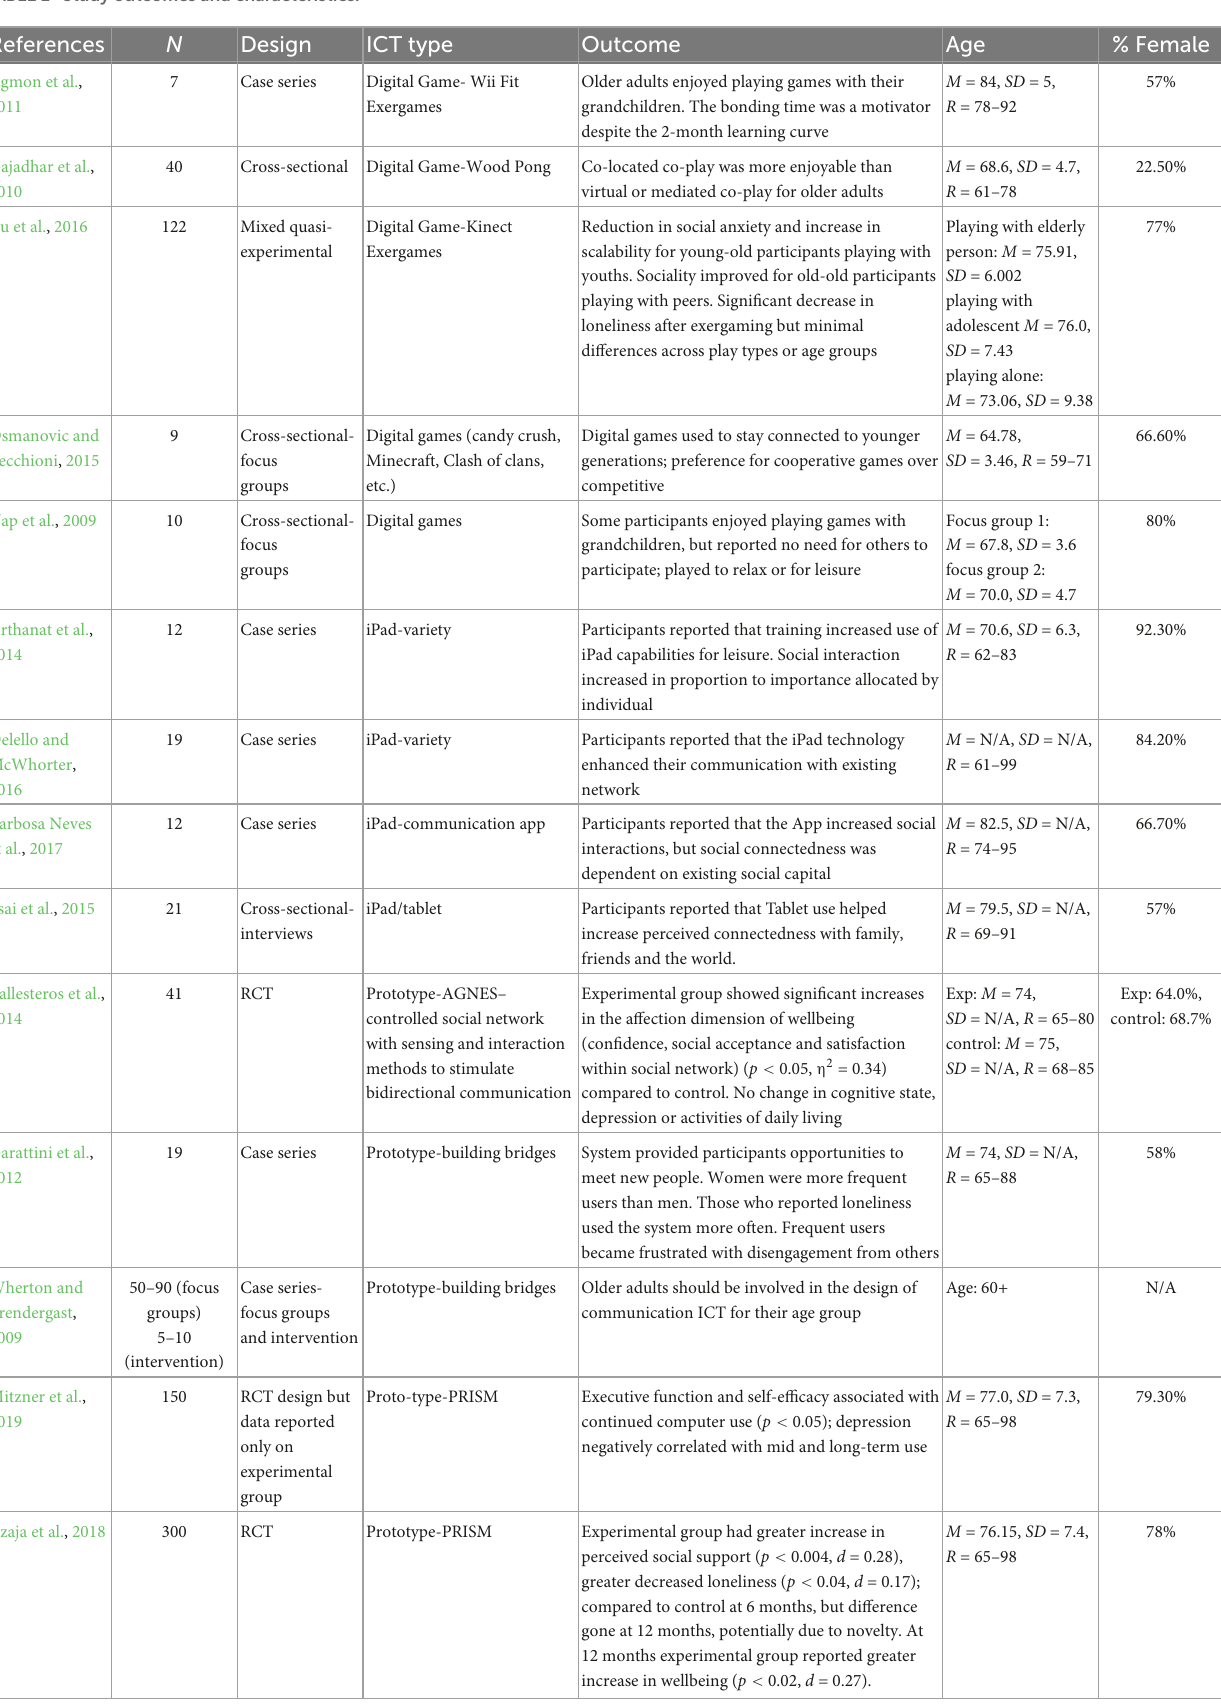
TABLE 1 Study outcomes and